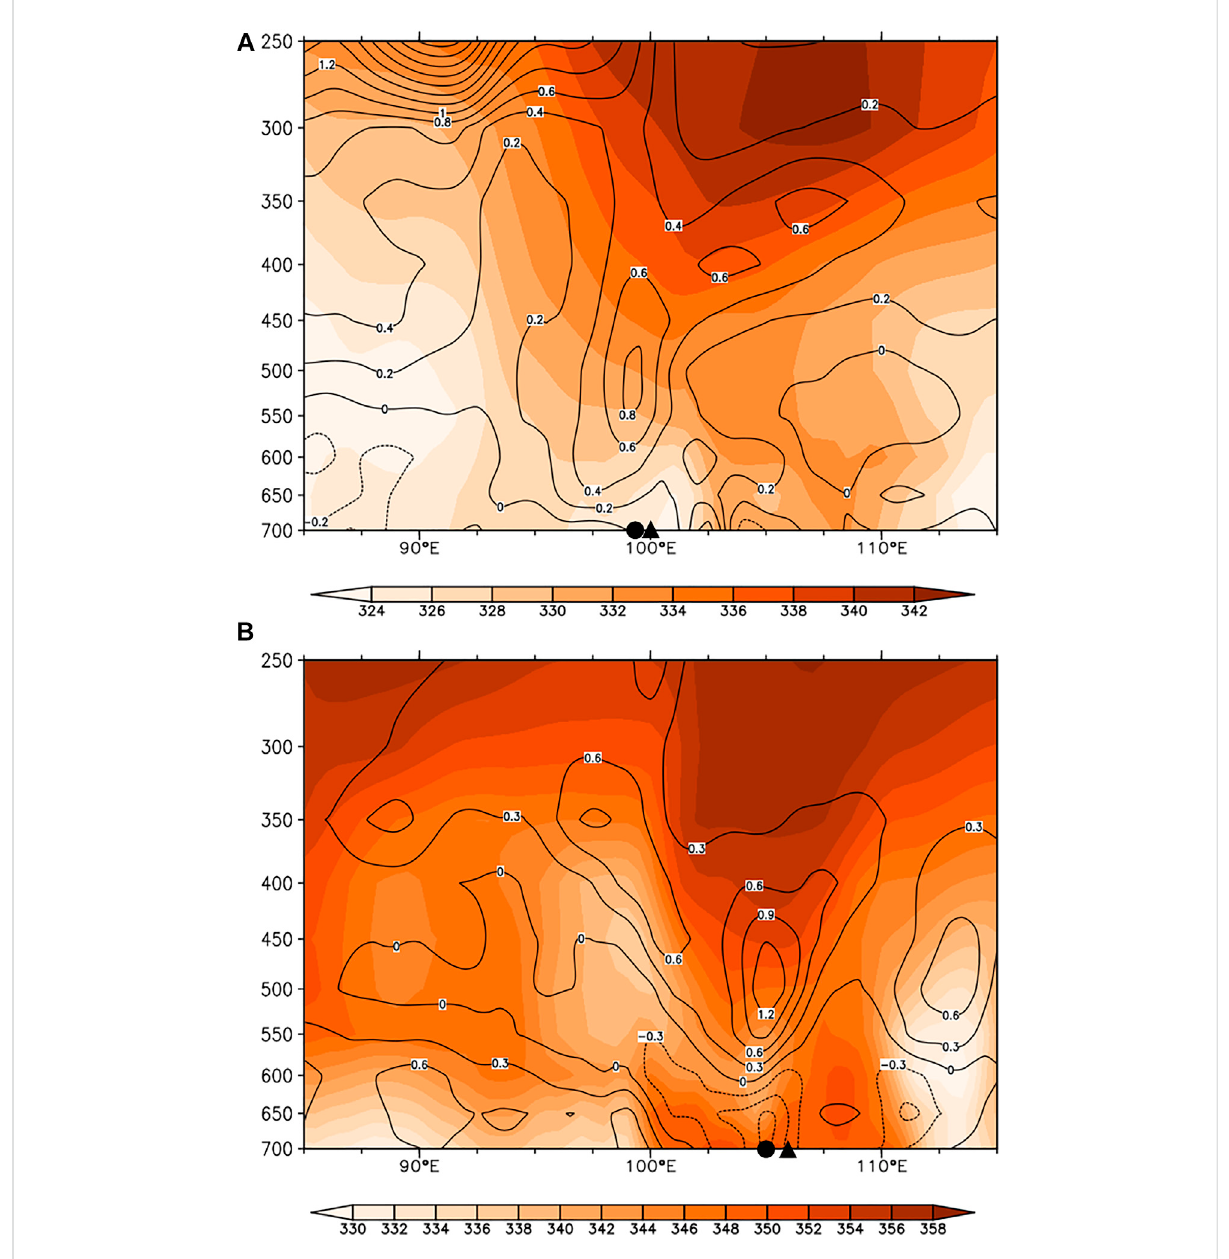
FIGURE 7 Thelongitude-heightpro fi leofMPV 1 (positivevalue:solidisoline;negativevalue:dashedisoline,Unit:PVU)and θ se (shaded,Unit:K)along40 °